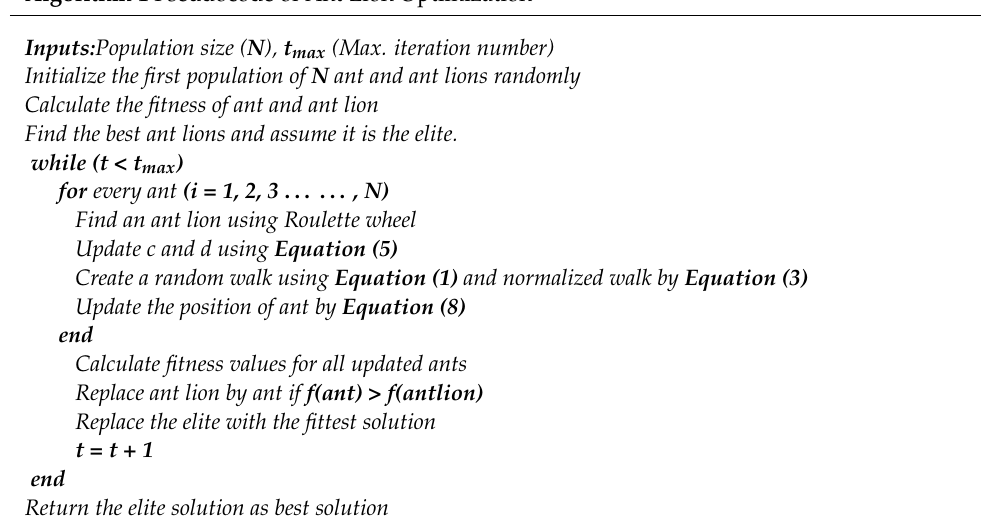
Algorithm 1 Pseudocode of Ant Lion